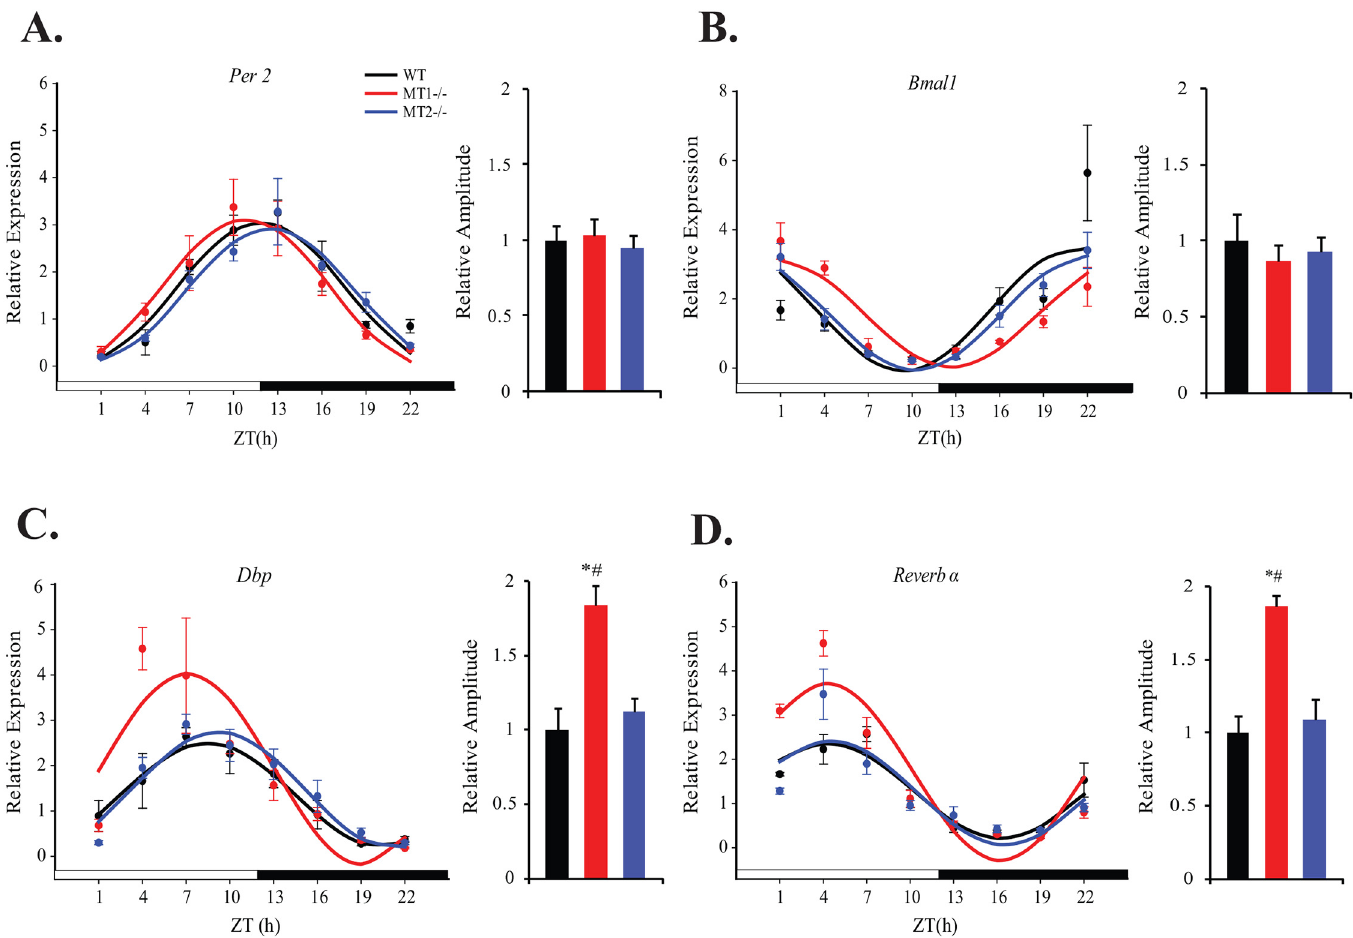
Fig 2. Expression levels of clock and clock controlled genes within skeletal muscle of WT, MT1 -/- , and MT2 -/- mice. For each respective plot: the black circle (WT), red circle (MT 1-/- ) and blue circle (MT 2-/- ) indicate the expression levels of target genes calculated relative to the average expression of each dataset throughout the 24hrs. Results are represented as mean ± SEM. The black (WT), red (MT 1-/- ) and blue (MT 2-/- ) lines represent the periodic sinusoidal functions determined by COSINOR analysis (p < 0.05, (N = 4 – 6 for each time point and genotype).The bar graphs corresponding to each plot depict the amplitude of each oscillating transcript as calculated by COSINOR analysis and normalized to the value of the WT amplitude. *** p < 0.001, One-Way ANOVA (post hoc: Holm-Sidak) WT vs. MT 1 -/- ; ### p < 0.001, One-Way ANOVA (post hoc: Holm-Sidak) MT1 -/- vs. MT 2-/-